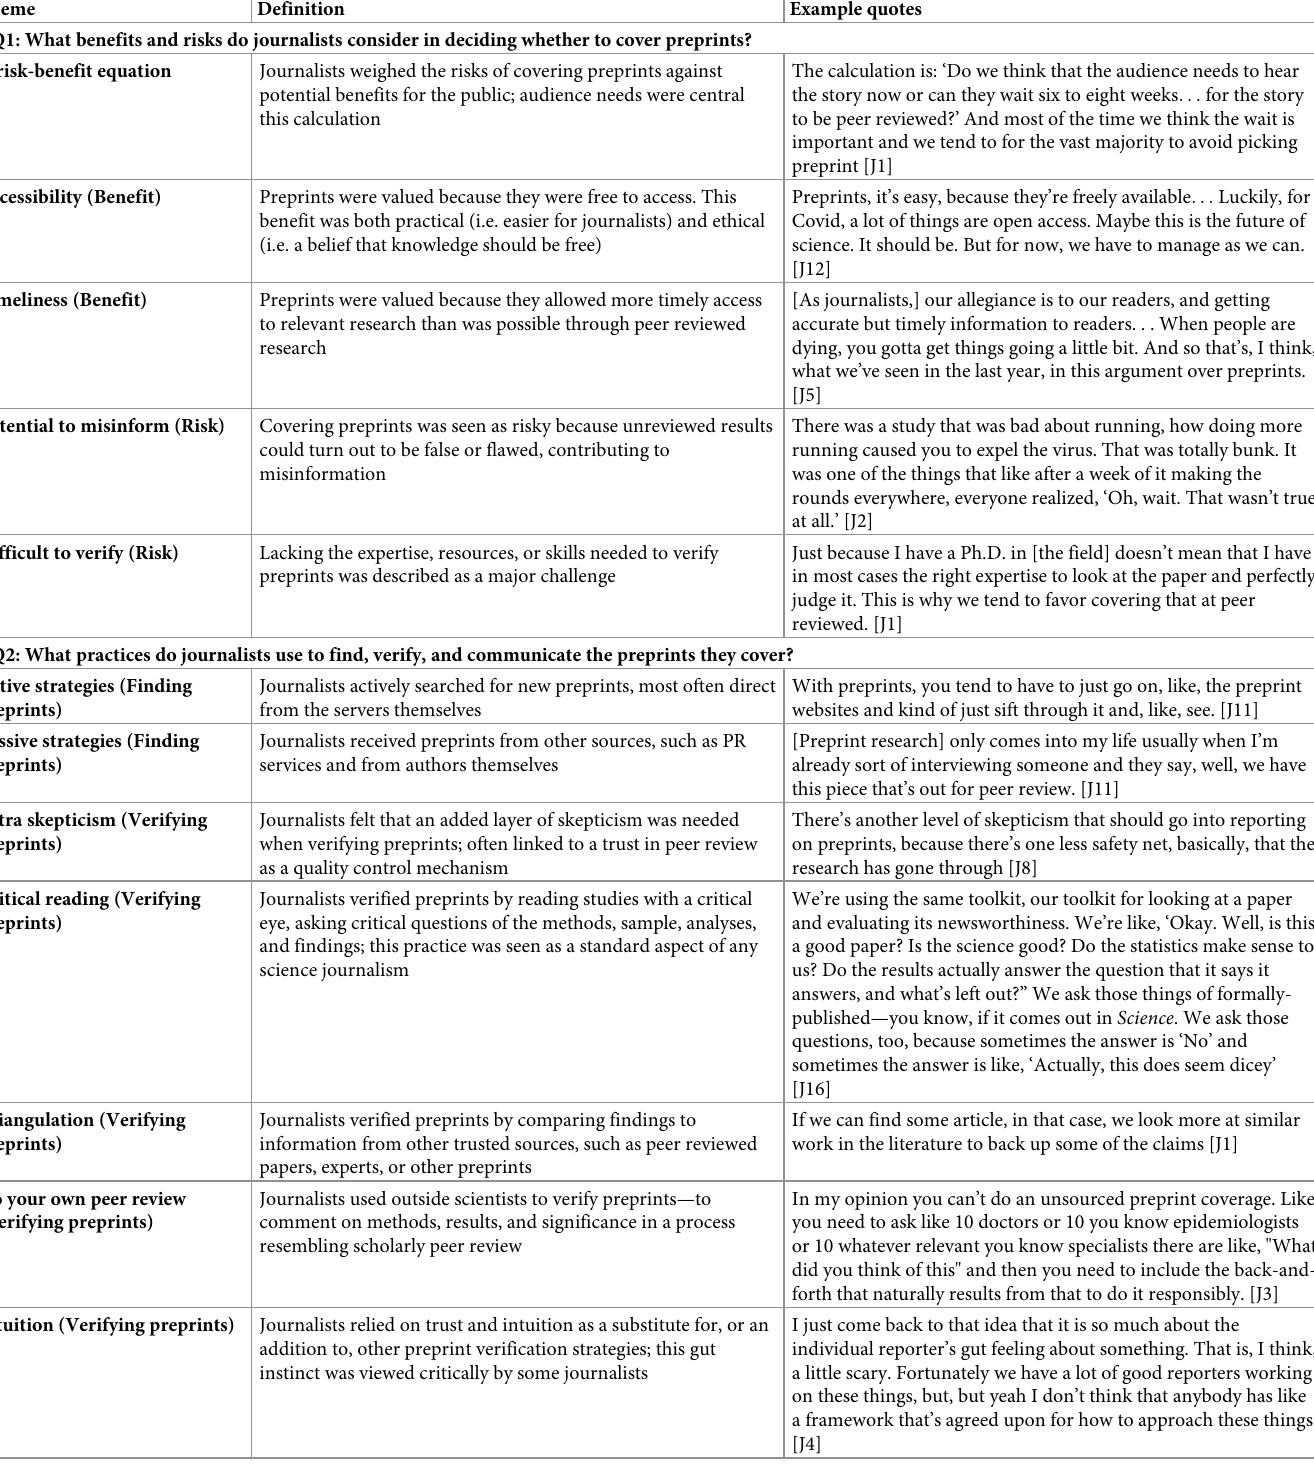
Table 3. Themes identified in interviews with journalists (n = 19) about their use of